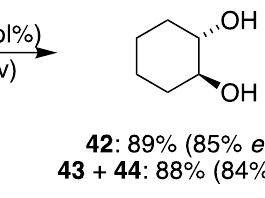
Figure 19. Self-assembling cooperative Co–salen catalysts 42 – 44 (blue = aromatic acceptor, red = aromatic donor).